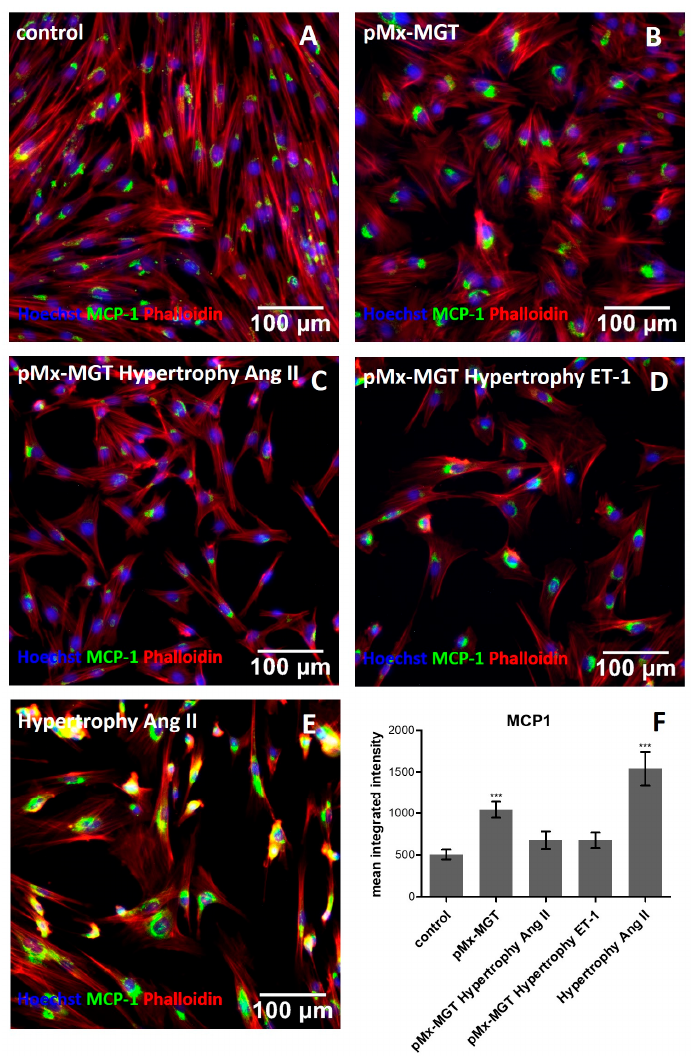
Figure 4. Immunofluorescence staining of MCP-1. ( A ) Control cells exhibit a mean integrated intensity of MCP-1 (green) of 505.1 ± 260.8 pixels/cell ( F ). Nuclei are counterstained with Hoechst (blue) and cytoplasm with phalloidin (red). ( B ) pMx-MGT -transfected Isl1 + Sca1 + ckit + pCPCs had a significant increase in MCP-1 expression (1040.0 ± 430.9 pixels/cell; f) ( C and D ); pMx-MGT Ang II and pMX- MGT ET-1 cells showed no significant change in MCP-1 expression (676.3 ± 421 pixels/cell; 675.5 ± 409.1 pixels/cell; F ). ( E ) Ang II stimulated Isl1 + Sca1 + ckit + pCPCs expressed a significantly higher MCP- 1 integrated intensity with a p = 0.0001 (1541.0 ± 880.9 pixels/cell). *** p ≤ 0.001.